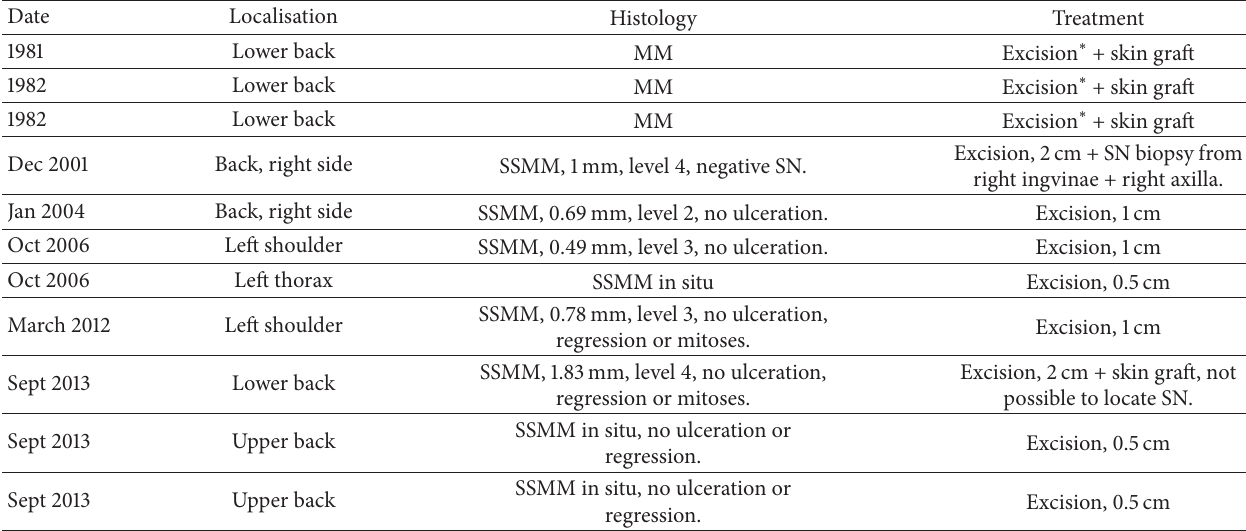
Table 1: List of melanomas in the reported case.